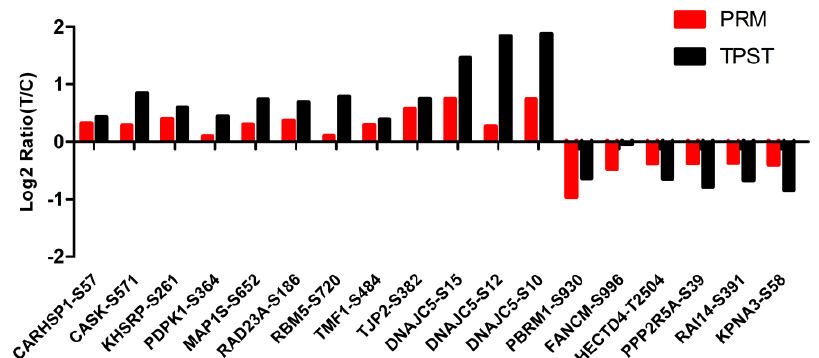
Figure 8. The validation results of the phosphorylation modification site with PRM. The x − axis is the significant phosphorylated modification site, and the y − axis is Log2-fold enrichment of treated /control (T/C) group.